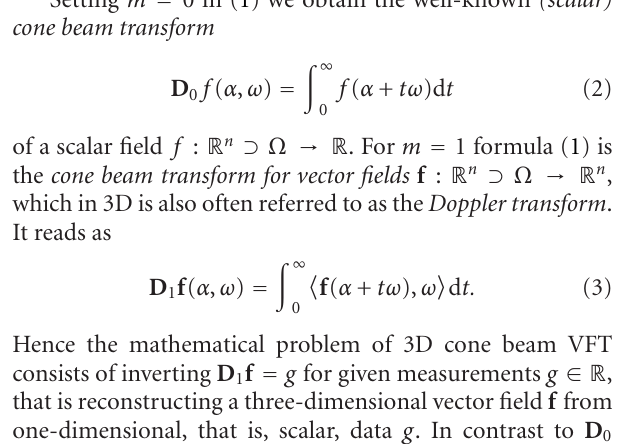
Figure 1: Measurement setup using a circle in the plane { x 3 = 0 } as scanning curve Γ